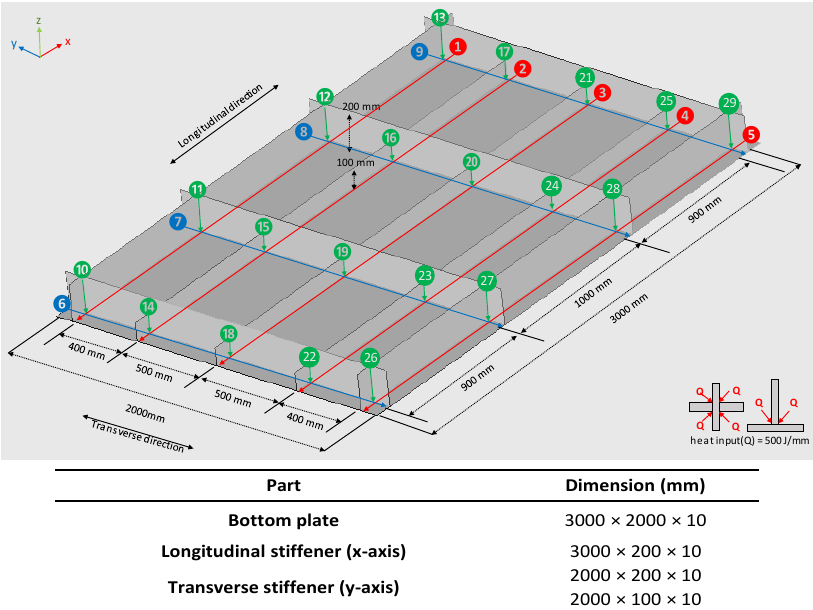
Figure 6. General ship grillage structure.